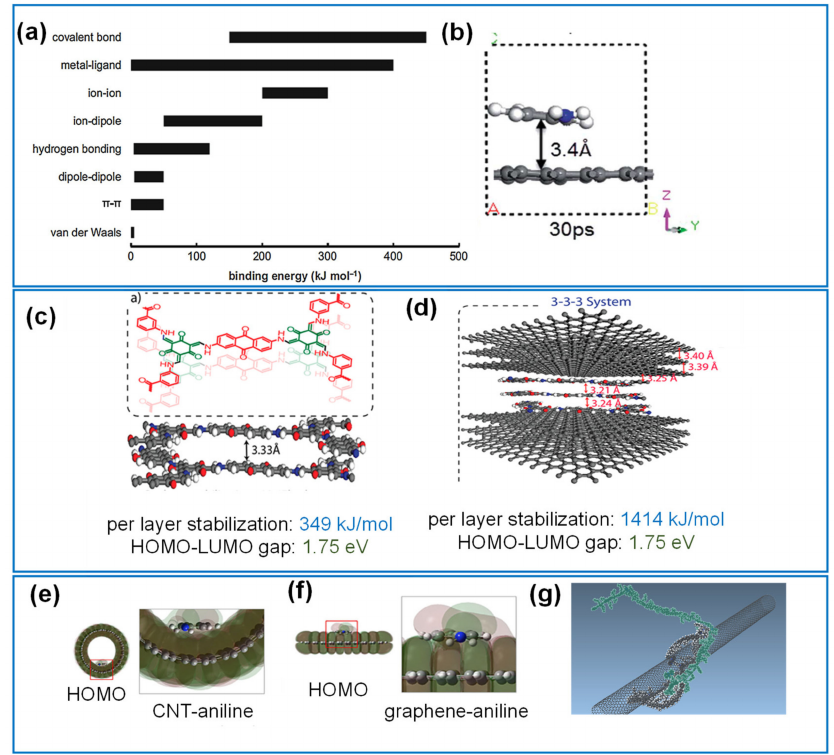
Figure 6. Simulation of the interactions between redox active molecules with carbons. ( a ) Binding energies of different types of interactions. Noncovalent interactions include vdW, π - π , H-bonding, ion-dipole and ion-ion types. ( b ) Interaction configurations of graphene-PANI system via AIMD from 5 ps to 30 ps time frames. ( c ) DFTB model structures of DqTp COF, and ( d ) graphene and 3-3-3 COF-planar. HOMO and LUMO structures of aniline bound to the ( e ) inner surface of the CNT, and ( f) to flat graphene. ( g ) Two fluorene/carbazole copolymers demonstrating inter-chain steric hindrance. Reproduced with permission from Refs.